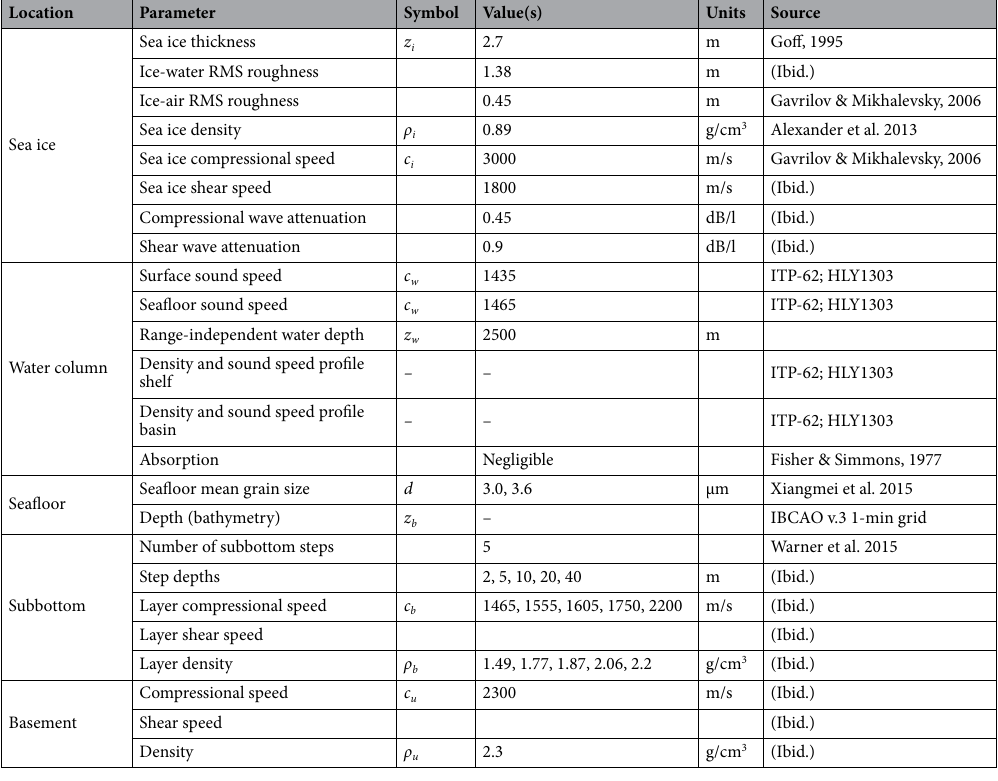
Table 3. Acoustic model